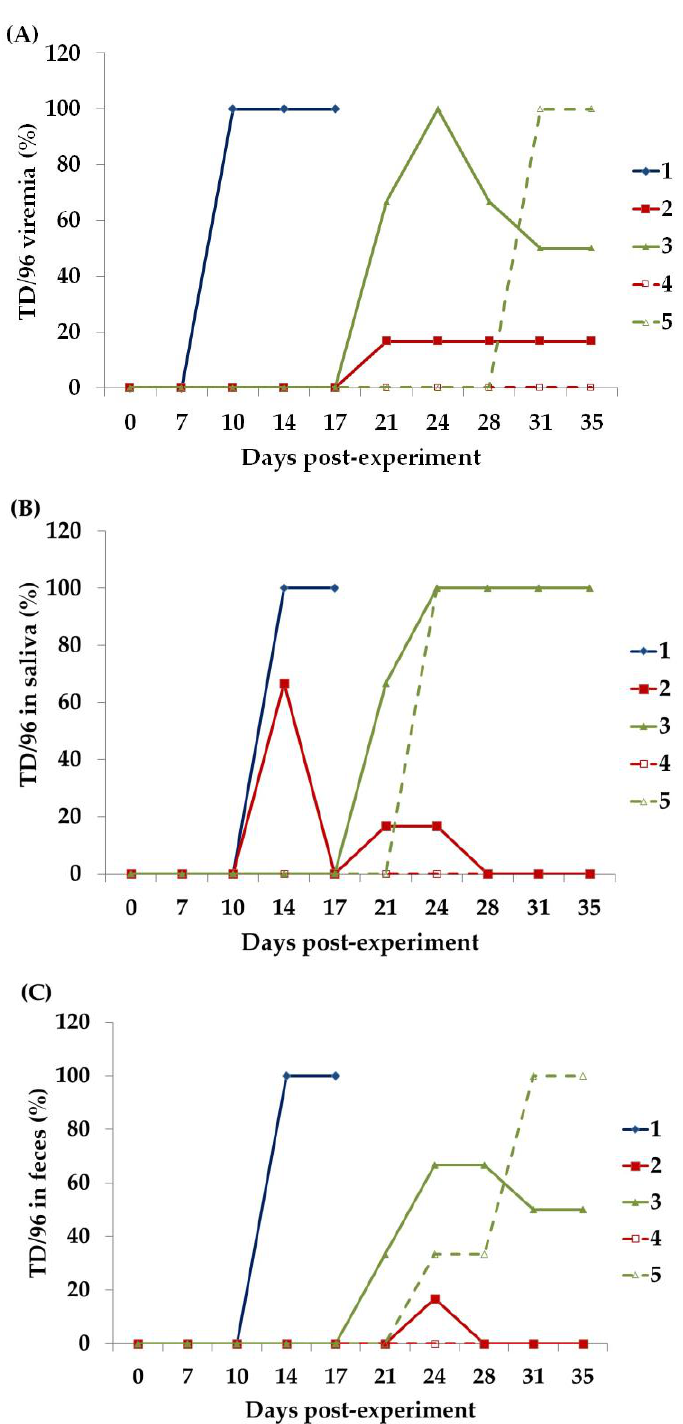
Figure 2. Number (percentage) of piglets positive for TD/96 as detected through QRRT-PCR [20] of the ( A ) blood, ( B ) saliva, and ( C ) feces of the piglets in each group during the experimental period. The Group 1 piglet was inoculated oronasally with TD/96 at 7 DPE and served as the CSFV donor (i.e., primary invader) for Groups 2 and 3. The piglets in Group 2 that underwent LPC vaccination at 0 DPE and those in Group 3 that did not undergo LPC vaccination cohabited with the Group 1 piglet from 7 – 17 DPE. The piglets in Groups 4 and 5 cohabited with those in Groups 2 and 3 (i.e., secondary invaders), respectively, from 17 – 36 DPE.